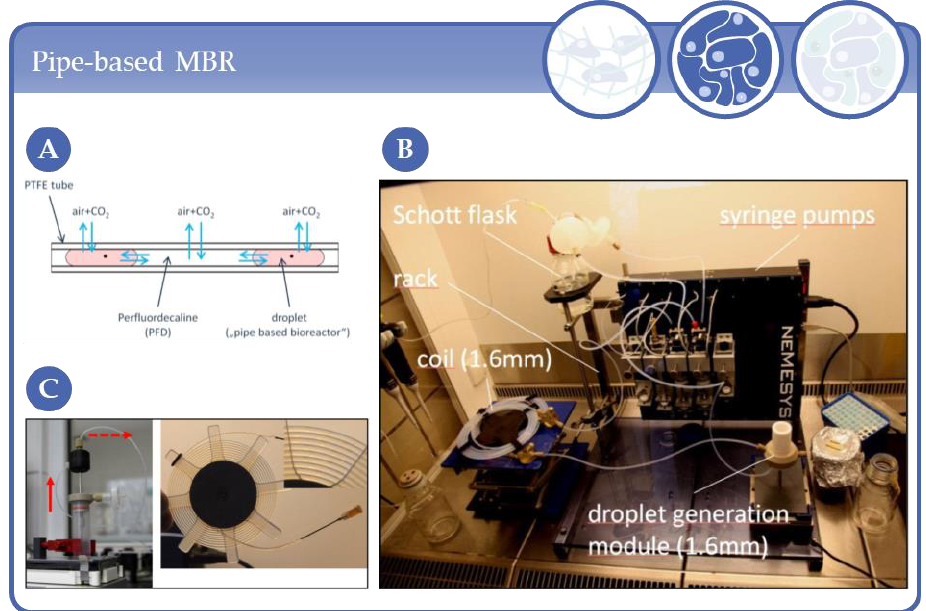
Figure 11. Pipe based micro-bioreactor (PBM) overview and basic set up with the capability of generating embryoid bodies by segmented flow. ( A ) Principle of gas exchange between PBM and an environment; ( B ) basic setup placed under a clean bench; ( C ) two capillary probe for 800 nL droplet generation within 1 mm coil (left hand side) and the 1 mm coil for cultivation of cells (right hand side). The enlarged section of the right hand side picture shows the droplets inside the PTFE tube. Reprinted with permission from [117]. Copyright © 2016, Karger Publishers.